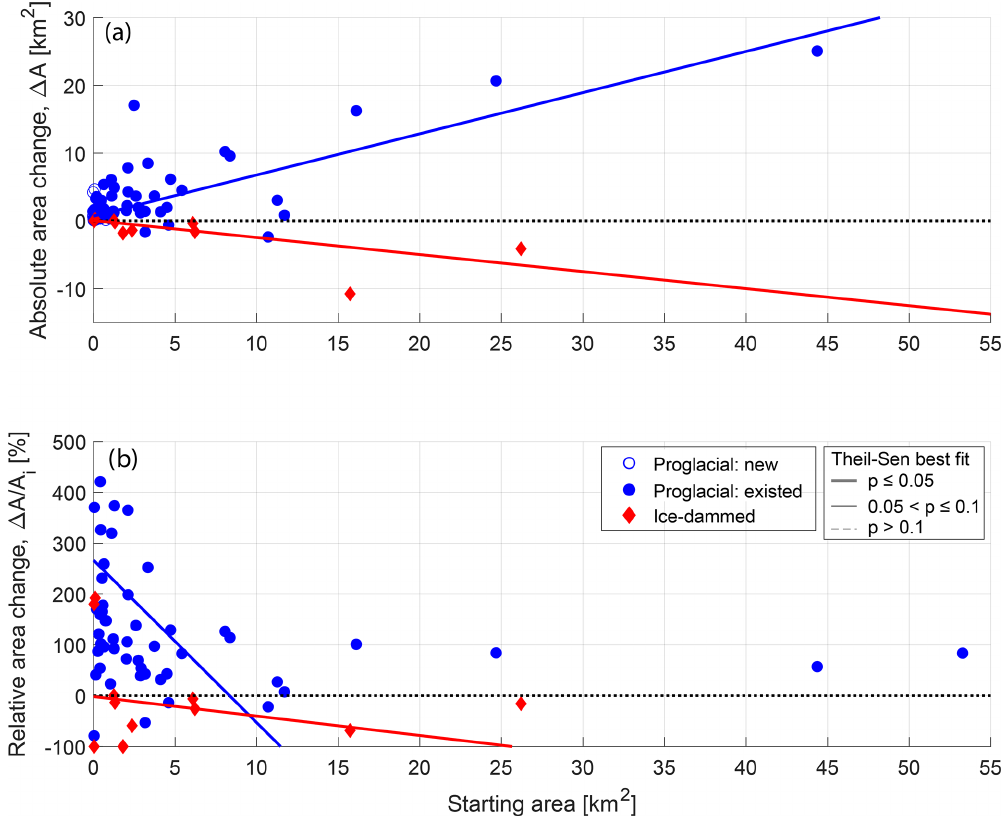
Figure 7. (a) Absolute lake area change as a function of initial lake area for all proglacial lakes (blue circles) and ice-dammed lakes (red diamonds). (b) Relative lake area change as a function of initial lake area. In both panels, lines show the linear fit to proglacial (blue) and ice-dammed (red) lakes as estimated to by the non-parametric Theil–Sen robust line. Thick solid lines show relationships that are significant at the p ≤ 0 . 05 level; thin solid lines show 0 . 05 < p ≤ 0 . 1 relationships, and thin dashed lines show p > 0 . 1 relationships. All significance values are estimated by the Kendall rank correlation test. The dotted black line shows zero lake area